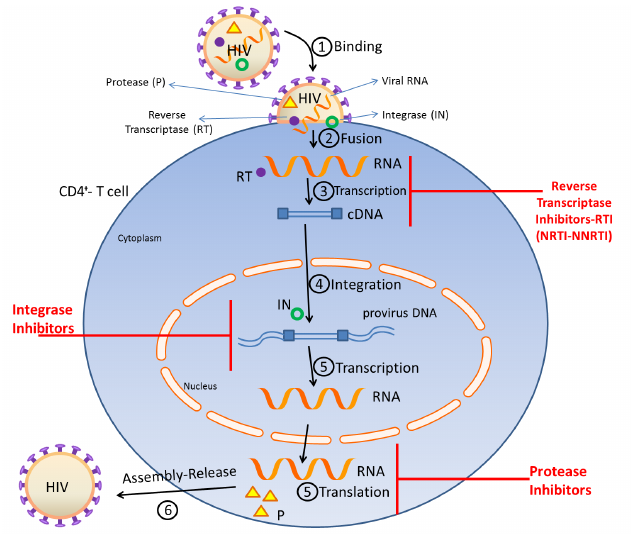
Fig. 1. Replication cycle-Treatment.